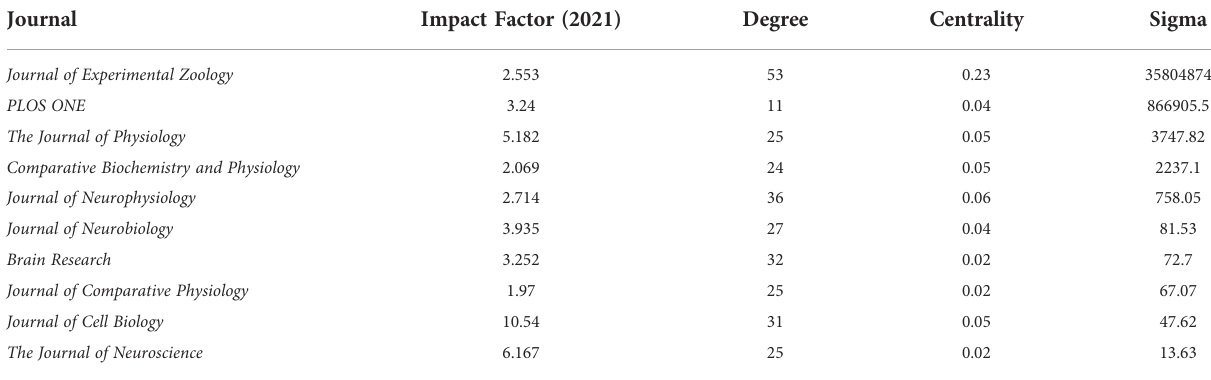
TABLE 2 Top 10 journal co-citation scores, based on the sigma